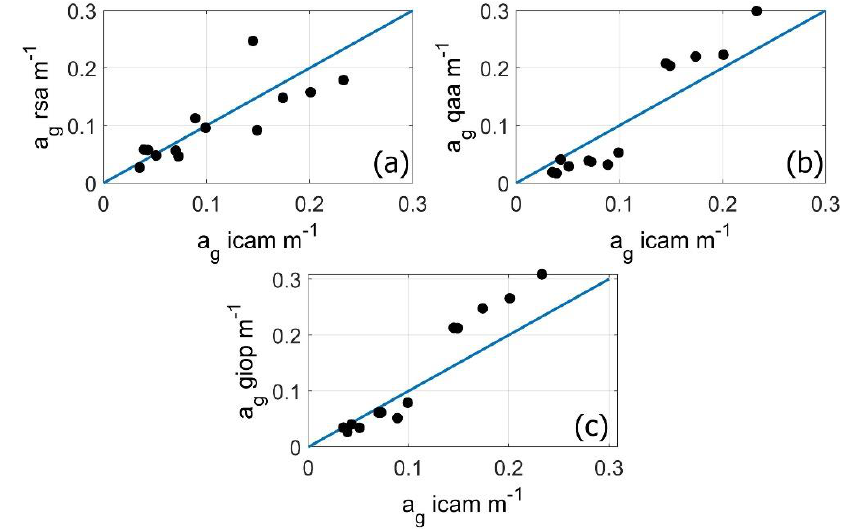
Figure 4. Comparison of the absorption values calculated from the R rs measurements by the floating (or deck) spectroradiometer using different algorithms with the values measured by the ICAM device for 13 stations. The solid line is 1:1 dependency. ( a )—RSA algorithm (RMSE = 0.042, RE = 40%); ( b ) QAA (RMSE = 0.04, RE = 38%); ( c )—GIOP (RMSE = 0.045, RE = 36%) (see Section